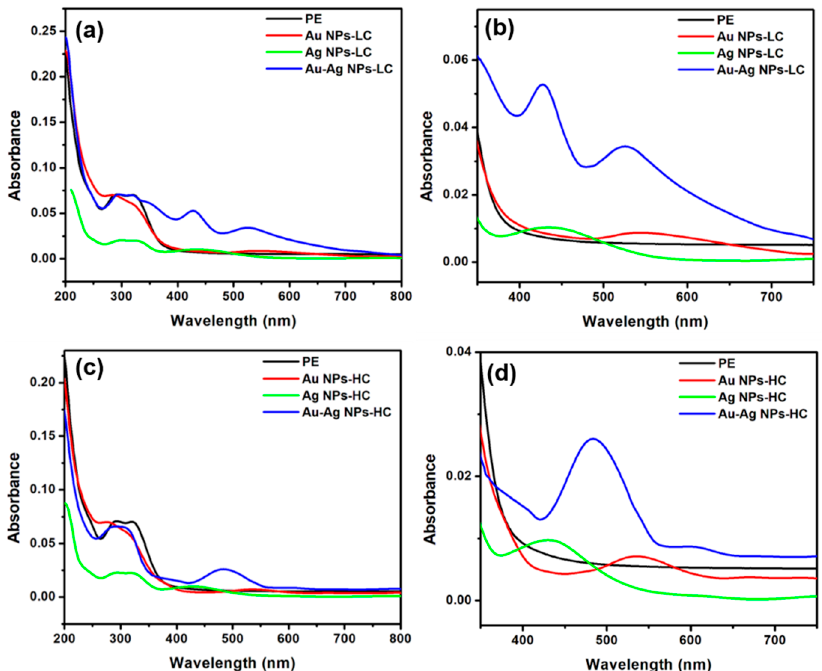
Figure 2. UV–vis spectra of Ag, Au, and Au–Ag bimetallic NPs with different concentrations of plant extract, i.e., (i) LC = low concentration of PE, (ii) HC = high concentration of PE. ( a ) UV–vis spectra of PE, Au, Ag, and Au–Ag phase segregated bimetallic NPs prepared with low concentration (LC) of plant extract (PE). ( b ) Zoom-in version of the surface plasmon bands related to the spectra shown in ( a ). ( c ) UV–vis spectra of PE, Au, Ag, and Au–Ag alloy bimetallic NPs prepared with high concentration (HC) of plant extract (PE). ( d ) Zoom-in version of the surface plasmon bands related to the spectra presented in ( c